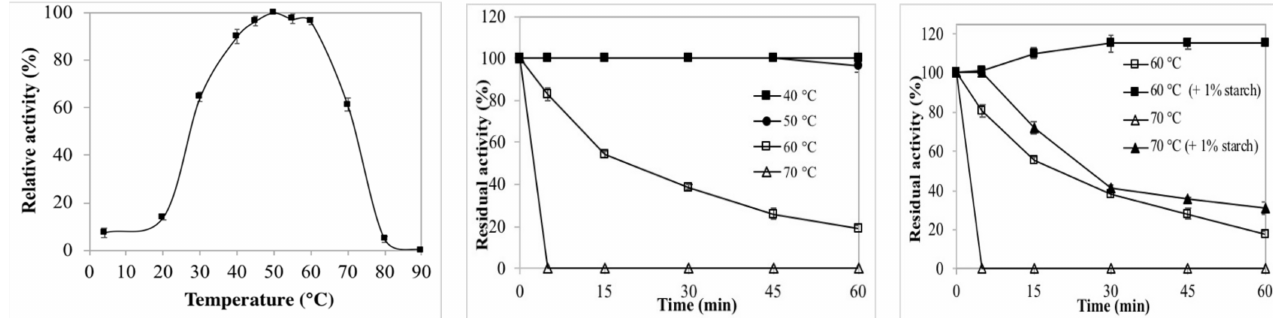
Figure 3. Temperature profile ( a ) and thermal stability of the purified BCA in the absence ( b ) and presence ( c ) of starch. Amylolytic activity was assayed at different temperatures ranging from 4 to 90 ◦ C at pH 8.0. The activity of the enzyme at 50 ◦ C was taken as 100%. To assess the thermostability of BCA, the enzyme was heated at the indicated temperatures. The effect of starch on the enzyme’s thermostability enhancement was also assessed. The residual activity was assayed at pH 8.0 and 50 ◦ C. The non-heated enzyme was taken as the control